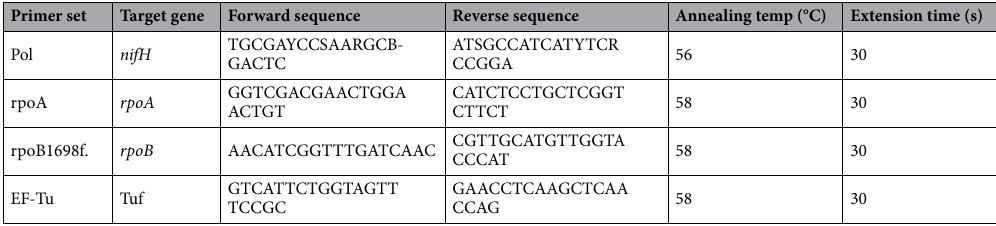
Table 3. Primers and PCR conditions used in this